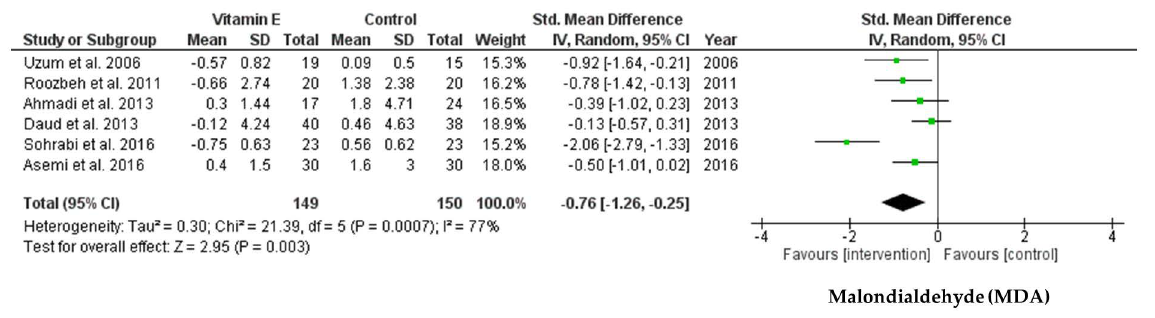
Figure 5. Forest plot for effect of vitamin E supplementation on malondialdehyde (MDA) in hemodialysis